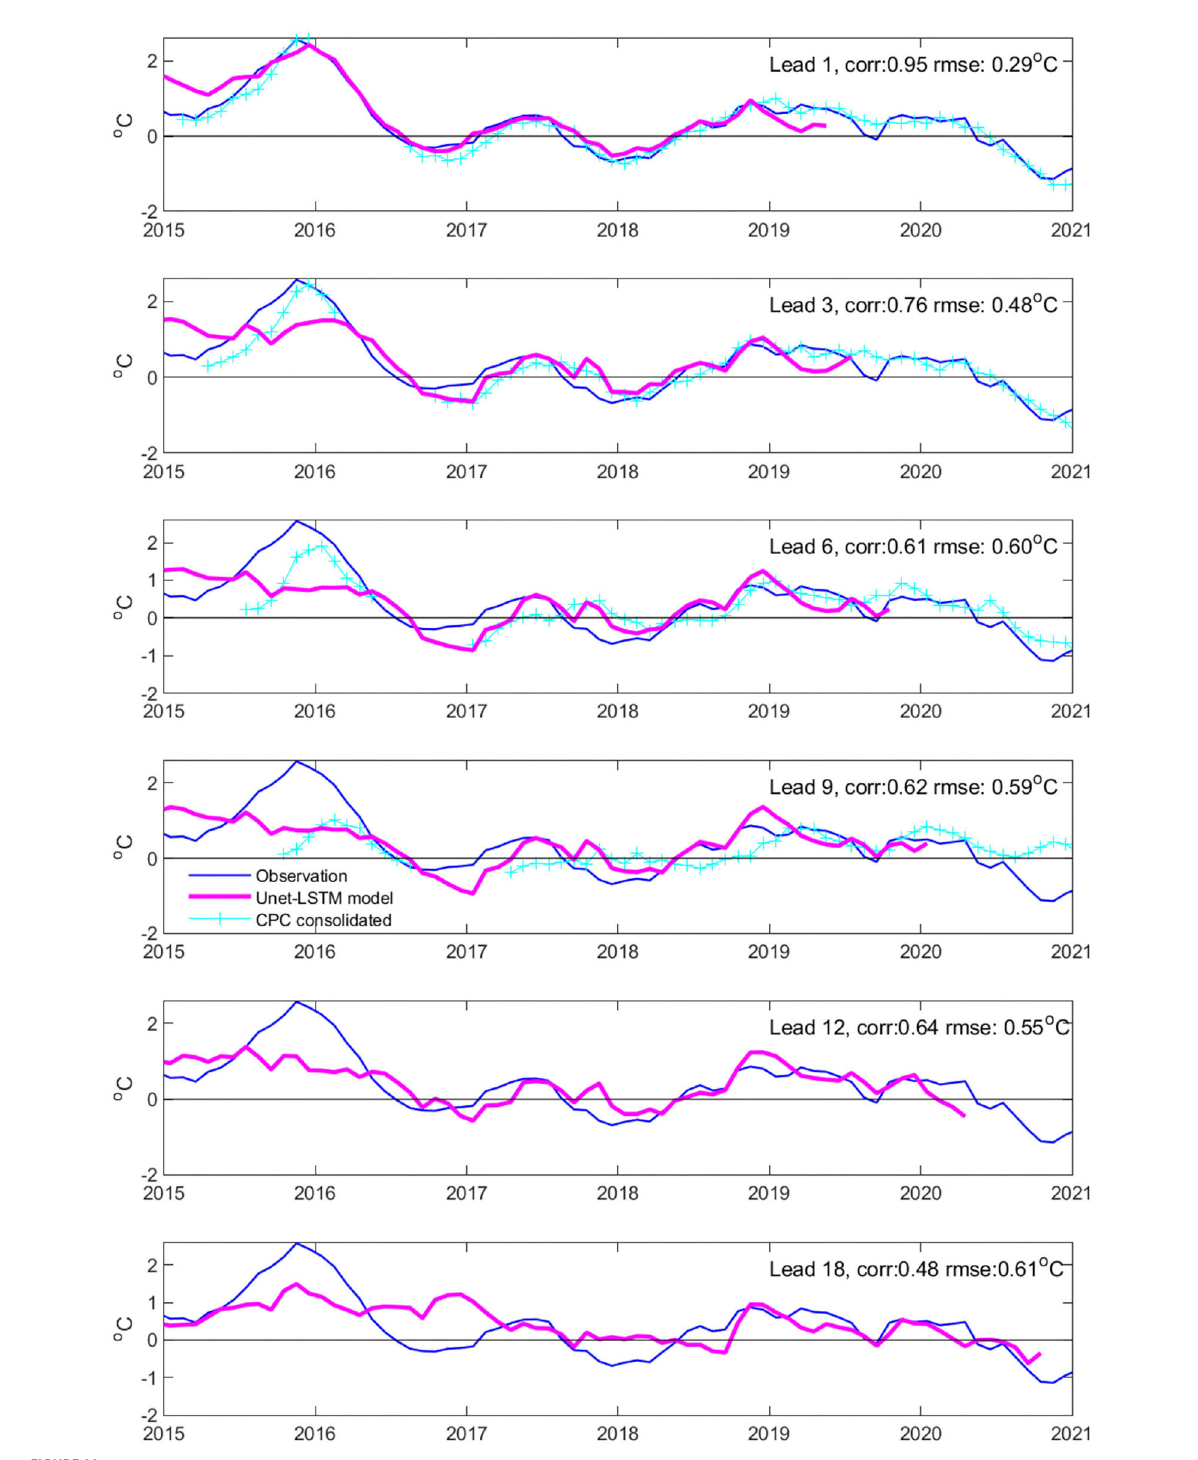
FIGURE11 Comparison between the Unet-LSTM model predictions of the Nino3.4 index during 2015-2020 and the consolidated predictions of the National Oceanic and Atmospheric Administration (NOAA) archived at the Climate Prediction Center (CPC) website (https://iri.columbia.edu/~ forecast/ensofcst/Data/archive/), with lead times of 1, 3, 6, 9, 12, and 18 months. The correlation and RMSE numbers are denoted for each lead time. The NOAA consolidated predictions are 3-month averages for up to a 9-month lead. In 2016, there are no NOAA consolidated predictions during the first 6 months. The ERA5 monthly Nino3.4 SST anomalies are plotted as